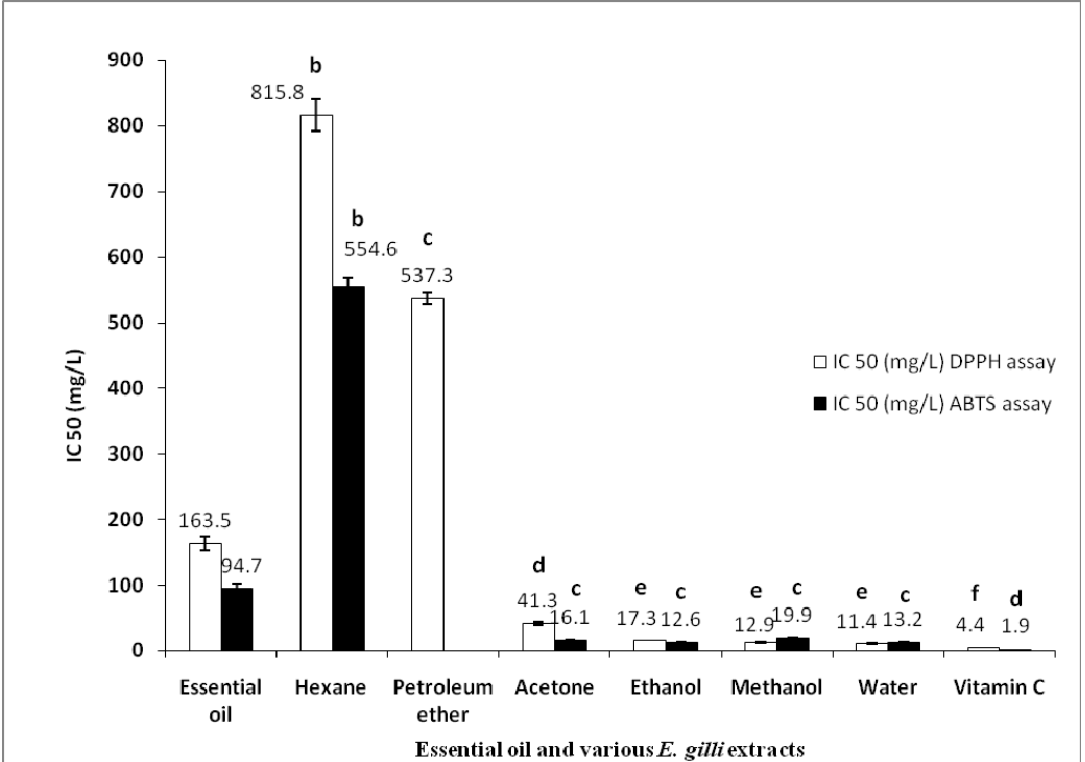
Figure 1. Free radical scavenging capacity [IC (mg/L)] of essential oil and E. gillii 50 extracts. Petroleum ether extract: not analyzed by ABTS assay. Different letters (a–f) on the tops of the square columns were significantly different ( p <